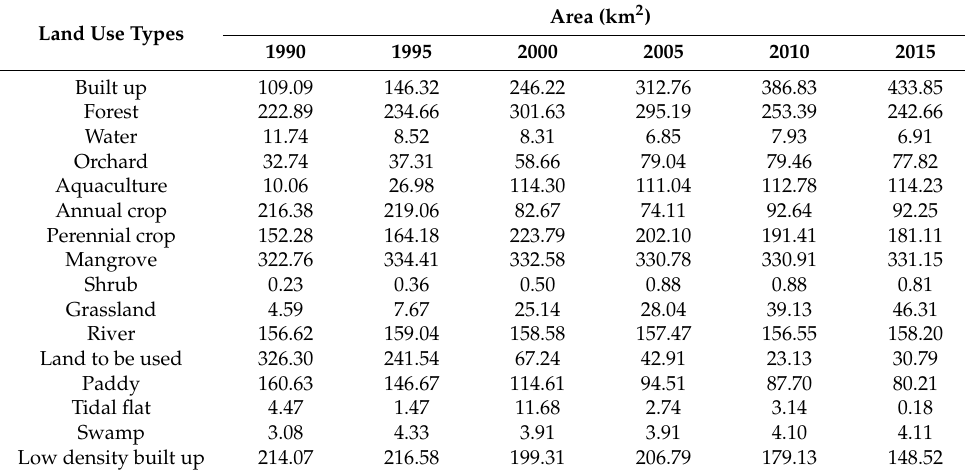
Table 8. Area of land use types in Ho Chi Minh City from 1990 to